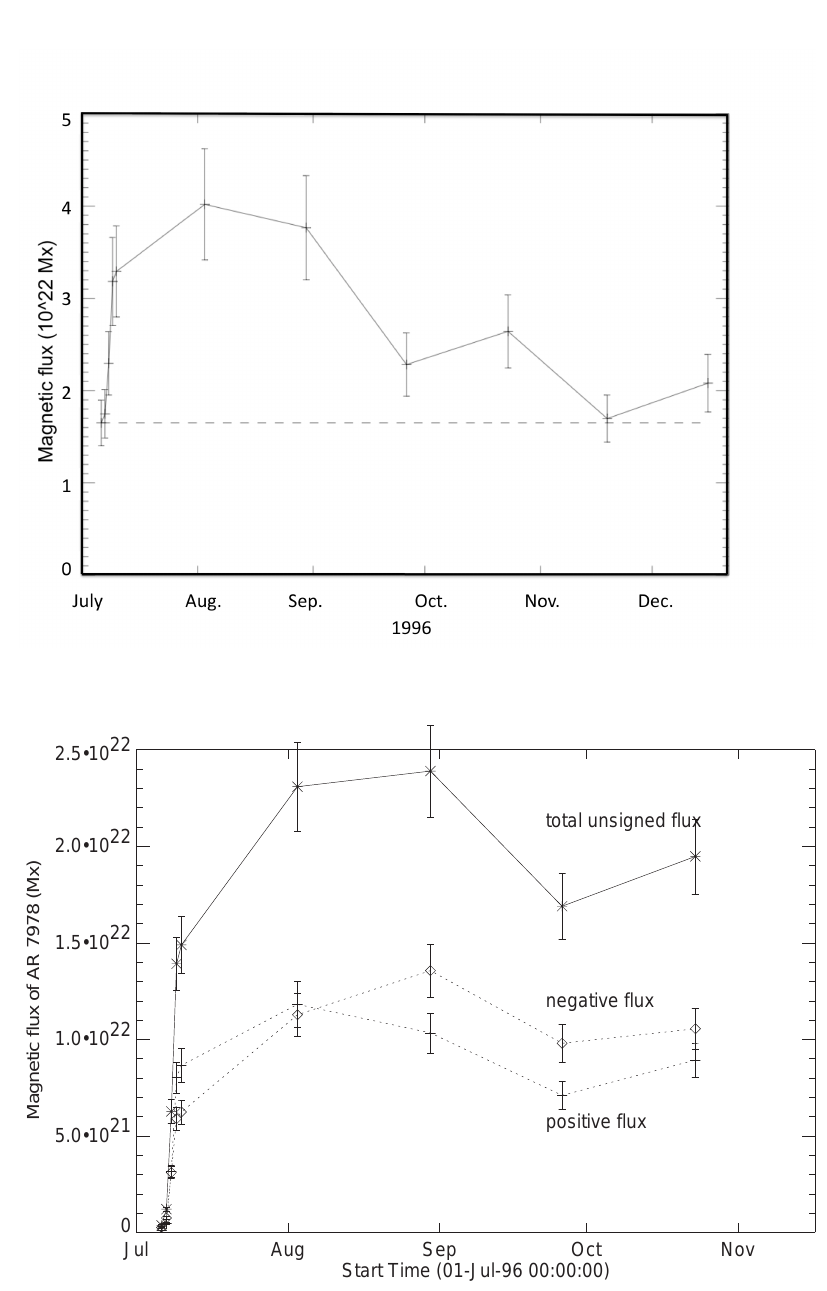
Figure 18: Evolution of magnetic flux versus time over increasing magnetic area of the AR (upper panel); and over a constant area (lower panel). Longitudinal MDI magnetograms at CMPs are used (cf. Figure 17). These flux values have not been corrected for MDI’s underestimation of magnetic flux values, as the data was not yet corrected for this at the time of these measurements, thus the flux values should be multiplied by a factor ≈ 1.45. However, this does not change the trend in the long-term evolution of the flux. The lower image reproduced with permission from van Driel-Gesztelyi et al. (2003b), copyright by AAS; see also van Driel-Gesztelyi et al.